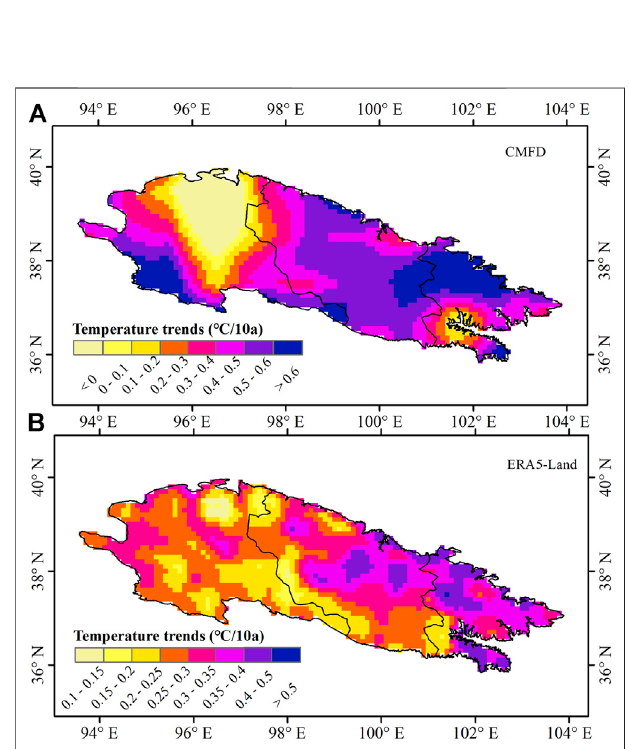
FIGURE 11 | Spatial distribution of temperature climate tendency rate in the Qilian Mountains for the period 1980 – 2018, from CMFD (A) and ERA5- Land (B)